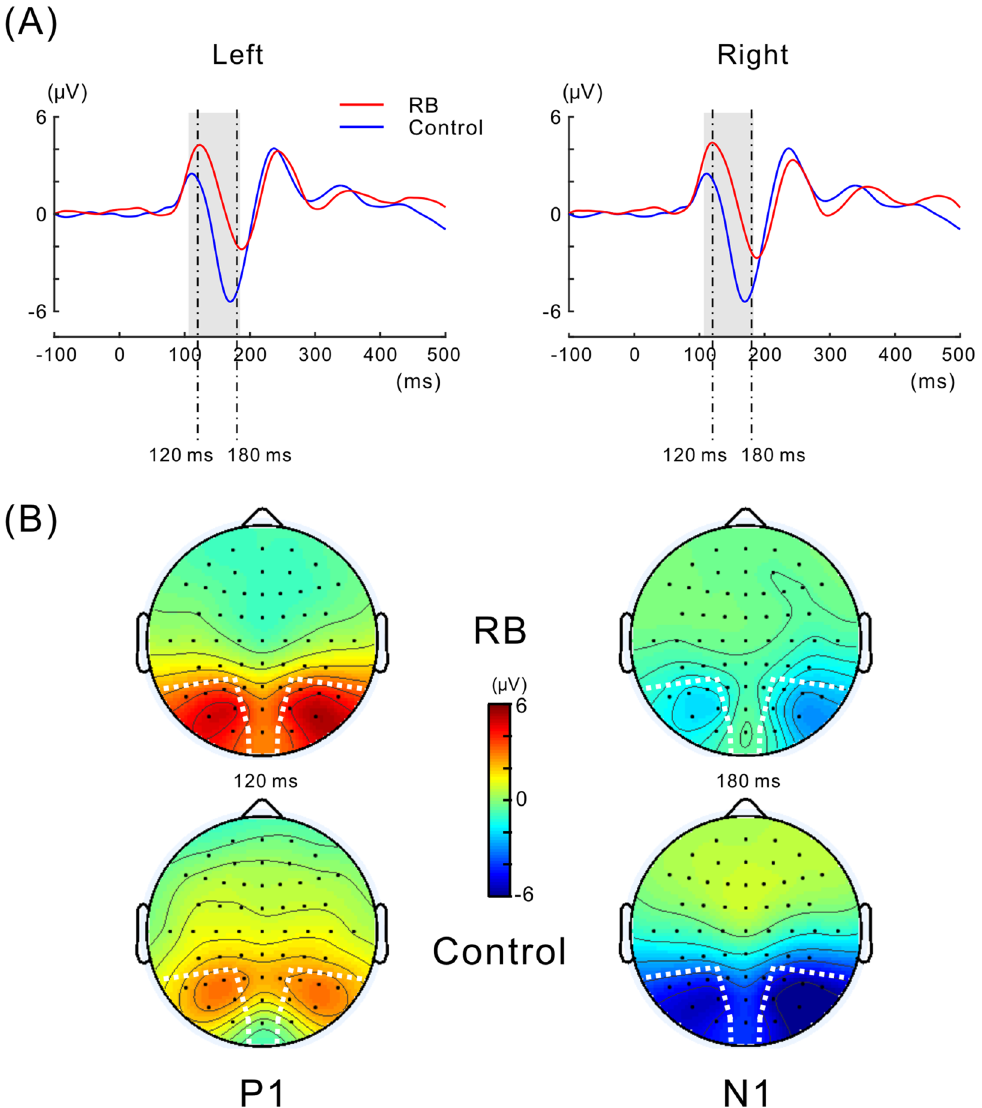
Figure 3. VEPs to the Necker lattice in the RB and Control conditions. ( A ) Grand-averaged VEPs at the left and at the right electrode ROIs. VEP waveforms recorded in the RB condition are depicted as a continuous line and those recorded in the Control condition are depicted as a dotted line. P1 amplitude at a latency of around 120 ms increased in the RB condition compared with that in the Control condition, whereas the N1 amplitude at the latency of around 180 ms decreased in the RB condition. The time interval in which there was a significant difference in VEP amplitude between the conditions is shaded in gray (for the procedures of the statistical analyses, see “Methods”). ( B ) Isocontour maps at latencies of 120 ms and 180 ms for the RB condition and Control condition. Both P1 (left panel) and N1 (right panel) were prominent at the posterior electrode sites in both conditions. Electrodes selected to define the electrode ROI were enclosed with a white dotted line for the left and the right